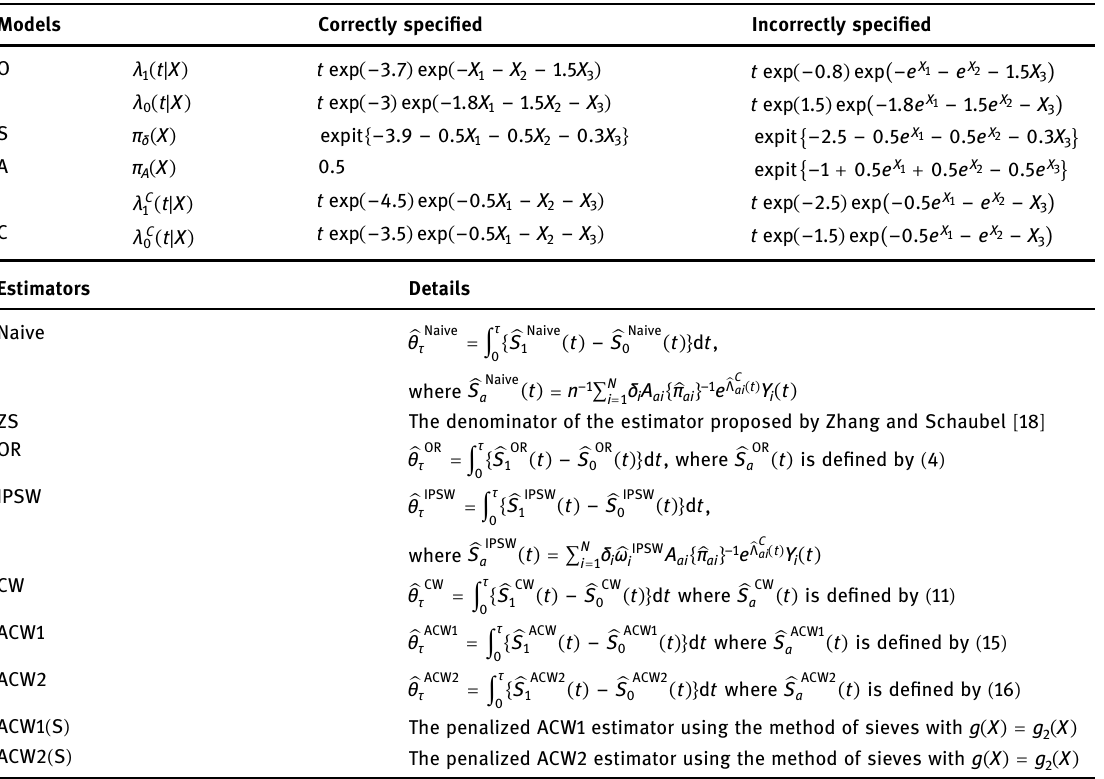
Table 1: Simulation settings: model speci fi cation and estimators; ( ) { ( )} = + x x expit score, A: treatment propensity score, C: